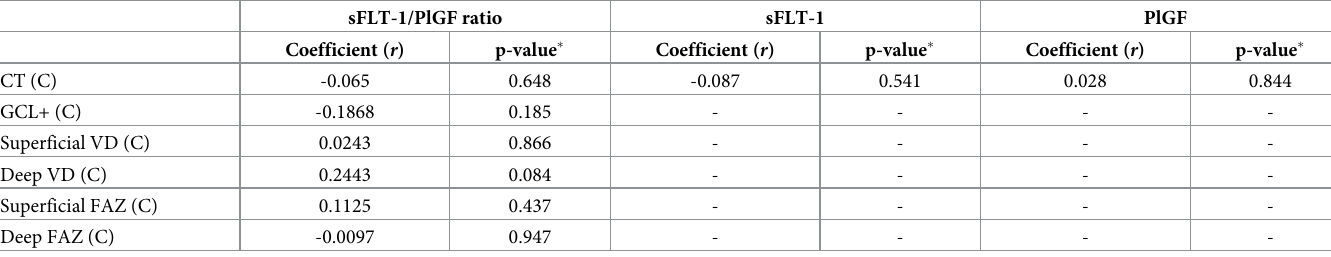
Table 3. Correlation between retinal factors and serologic